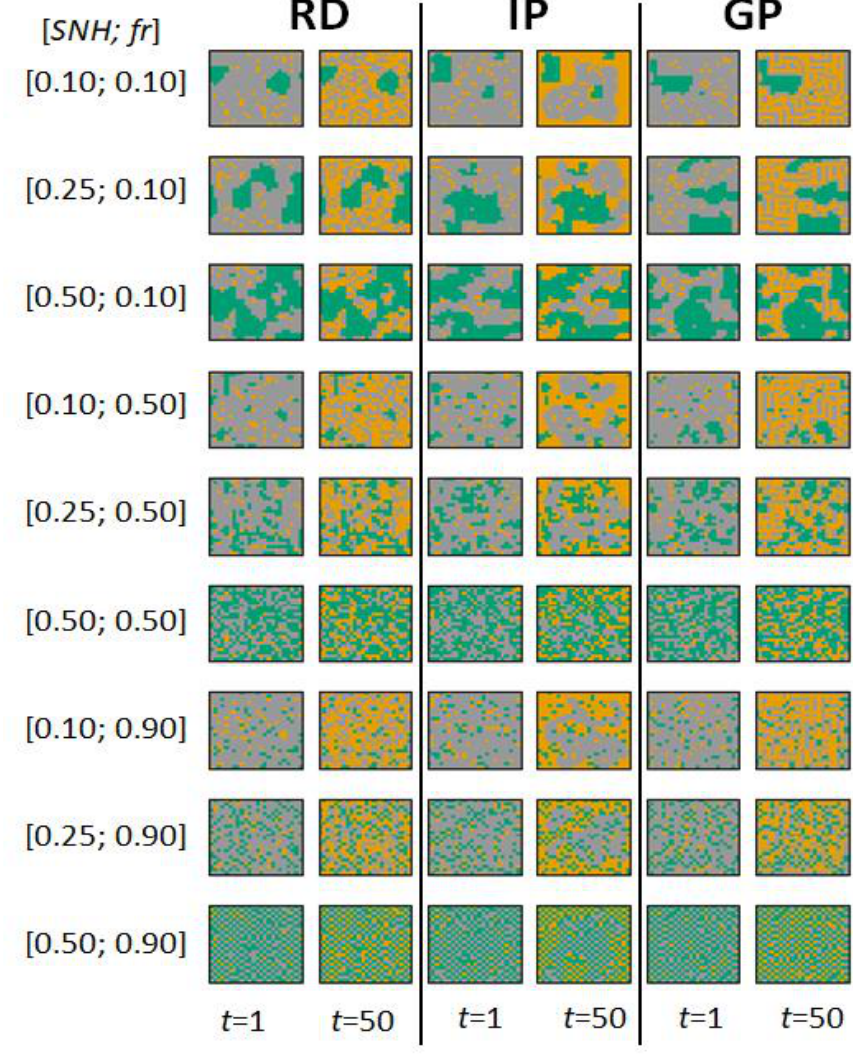
Figure 2 - Examples of landscape structures at the beginning (t=1) and the end (t=50) of the organic expansion. The figure provides one example landscape for each combination of landscape context and OF expansion scenarios. SNH= proportion of semi-natural habitat; fr : fragmentation of semi-natural habitat; RD, IP and GP refer to the three scenarios of selection of CF fields to convert to OF: selection of random, isolated or grouped fields; Grey: conventional (CF), orange: organic (OF), green: semi- natural habitat